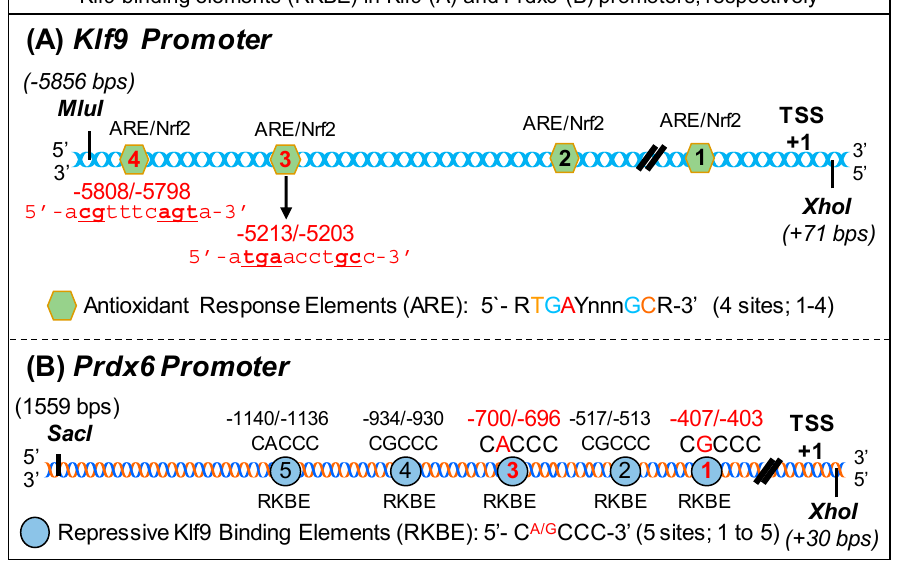
Figure 3. Diagrammatic sketch representing in silico analysis of putative Nrf2 and Klf9 binding sites in Klf9 and Prdx6 promoters, respectively. A tool for Motif discovery, MEME (Multiple Expectation maximization for Motif Elicitation), was used to spot out putative Nrf2 binding sites (ARE) and repressive Klf9 binding elements (RKBE) in Klf9 ( A ) and Prdx6 ( B ) promoters, respectively. Klf9 promoter bears four Nrf2/ARE (5 ′ -RTGAYnnnGC-3 ′ ) sites, as indicated in Figure 3A. Prdx 6 promoter bears five Klf9 repressive binding sites (5 ′ -C A/G CCC-3 ′ ), as indicated in Figure 3B.